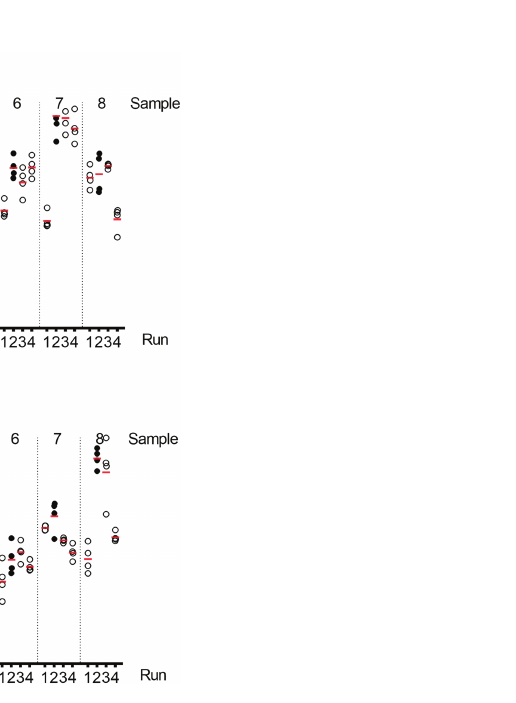
FIGURE 4 Frequencies of corrected A/California/07/2009-speci fi c (A) and B/Phuket/3073/2013-speci fi c (B) polypositive CD4 + T cells in eight different samples, from four different test runs by two different operators in assays of intra- and inter-assay precision. Eight different samples were tested, 2 high, 2 medium and 4 low responders. Each dot represents an individual background-corrected response reported as a percent of polypositive CD4 + T cells. The horizontal lines demonstrate the mean response for each sample per run. Each color represents a different